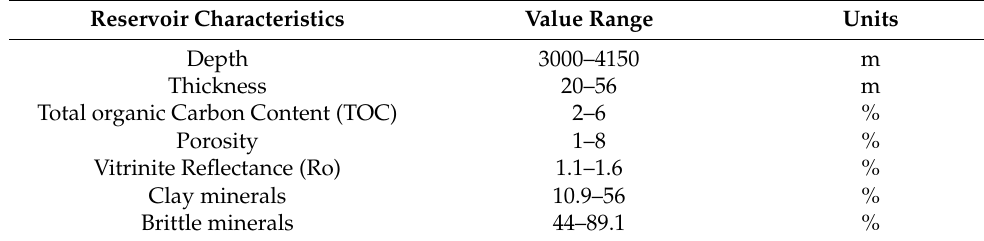
Table 1. Duvernay reservoir